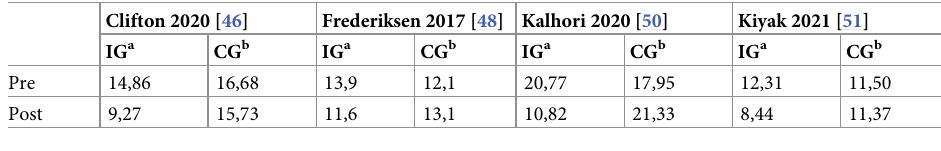
Table 6. BDI-II Means pre-treatment and